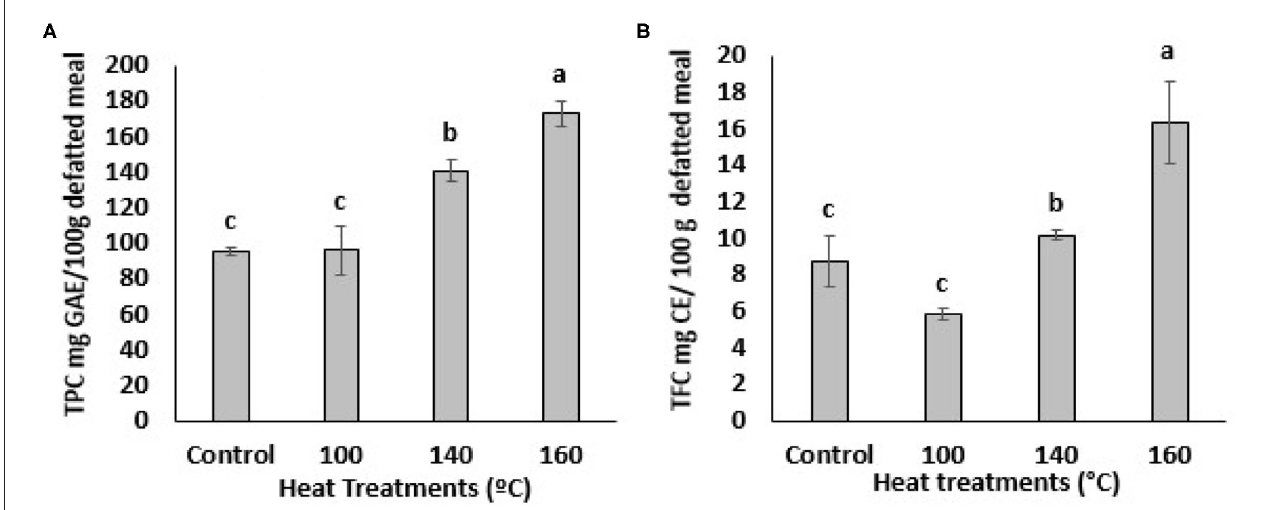
FIGURE 1 | Total Phenolic content (TPC) (A) and Total flavonoids content (TFC) (B) of BSG. Extracts from defatted meal affected by oven heat treatments. Data represents as mean ± SD ( N = 3). Mean followed by different letters are significantly different at p < 0.05. GAE, gallic acid equivalent; CE, catechin